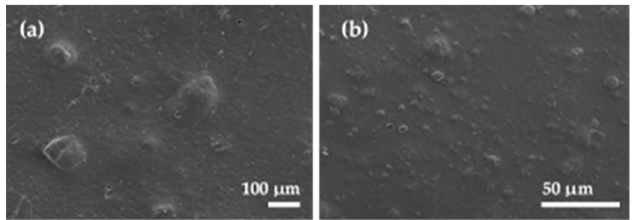
Figure A2. Representative SEM images of the substrate surface in contact with the film during the assembly with (a) lower and (b) higher magnification.